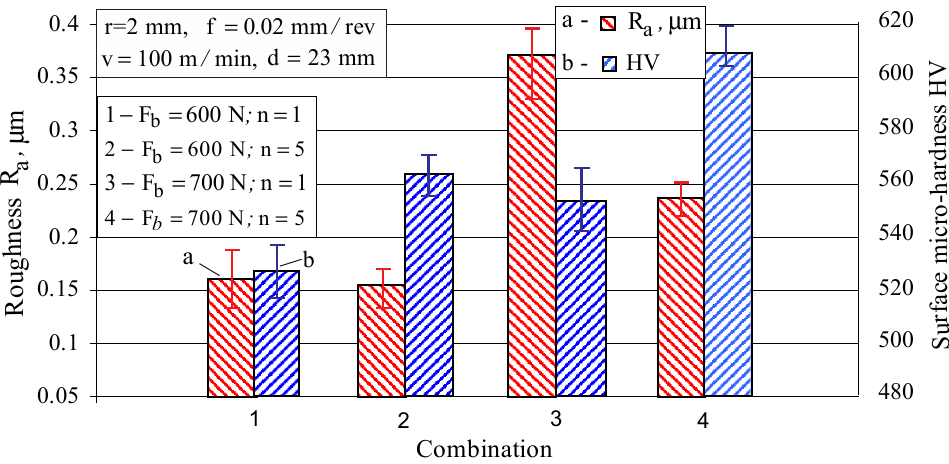
Figure 11. Some combination providing high micro-hardness.